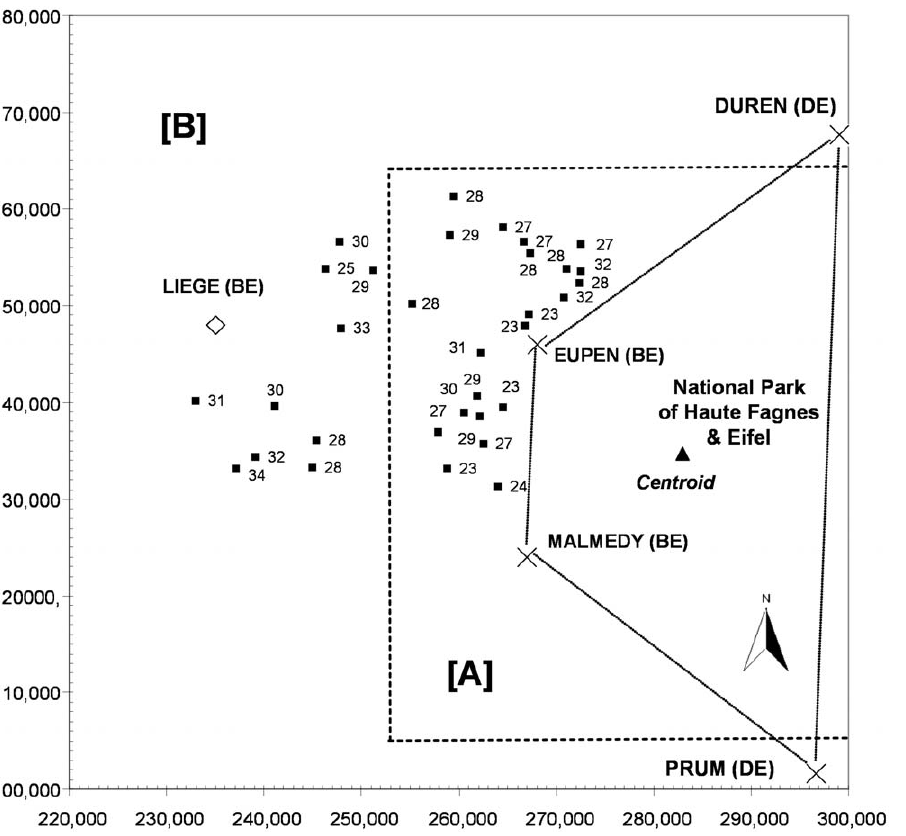
Figure 3. Spatial distribution of Cq values observed in cattle herds in the eastern part of the province of Lie`ge during the first 2 weeks after the appearance of bluetongue. [A] and [B]: Areas close to and remote from the National Park of Hautes Fagnes and Eifel, respectively. The two areas were delimited according to a distance of 30 km from the centroid of the National Haute Fagnes – Eifel. BE=located in Belgium; DE=located in Germany.